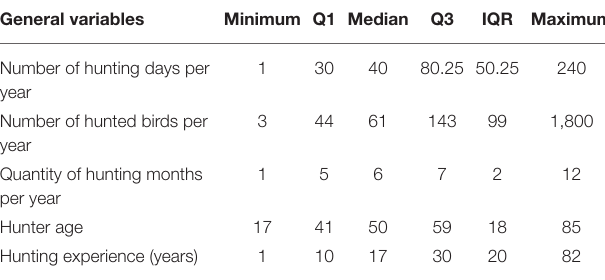
TABLE 2 | Interquartile ranges of quantitative and demographic variables of wild bird hunters surveyed from 2016 to 2018 (Q1: quartile 25%, Q3: quartile 75%, IQR: interquartile range).